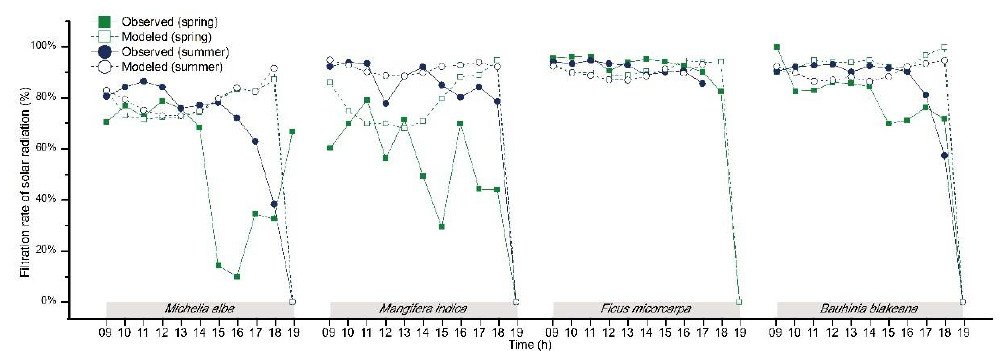
Figure 7. Comparison of modeled and observed solar radiation filtration rate.